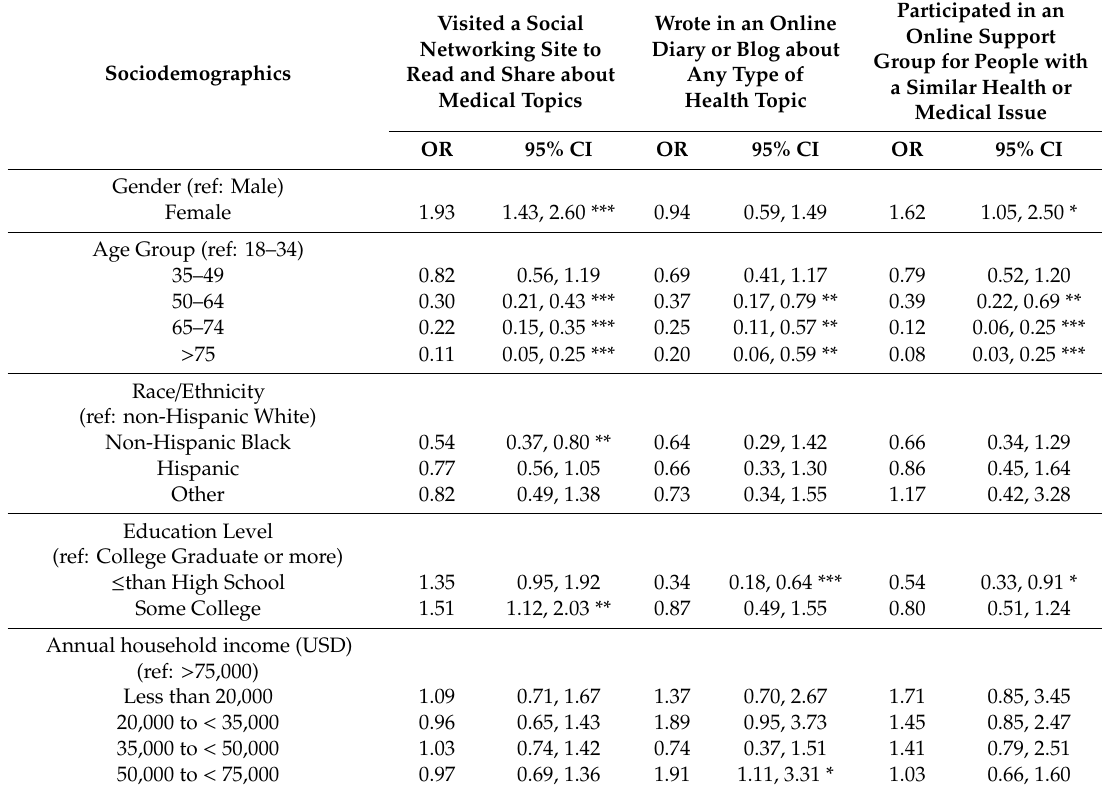
Table 5. Results of multivariable logistic regression models for the user-generated content / sharing domain outcomes ( N =